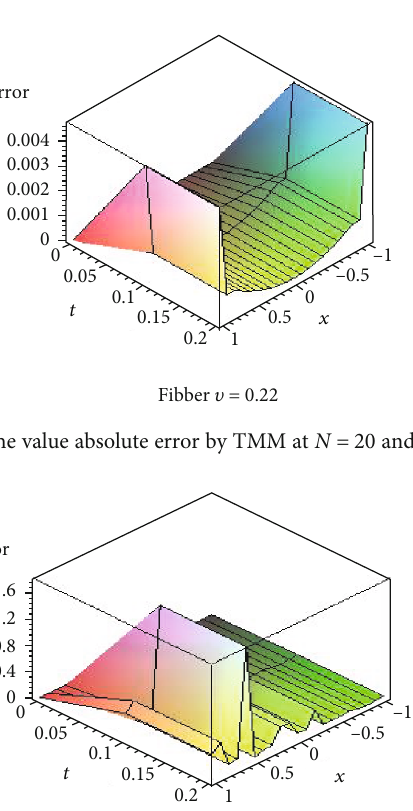
Figure 10: The value absolute error by TMM at N = 10 and T